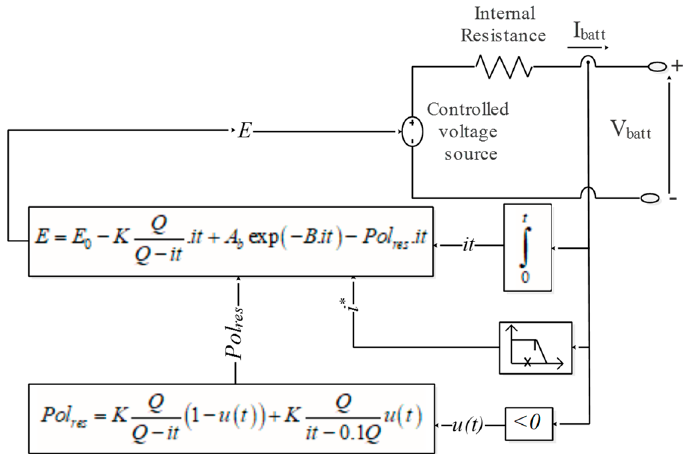
Figure 4. Li-ion ba tt ery model. Figure 4. Li-ion battery